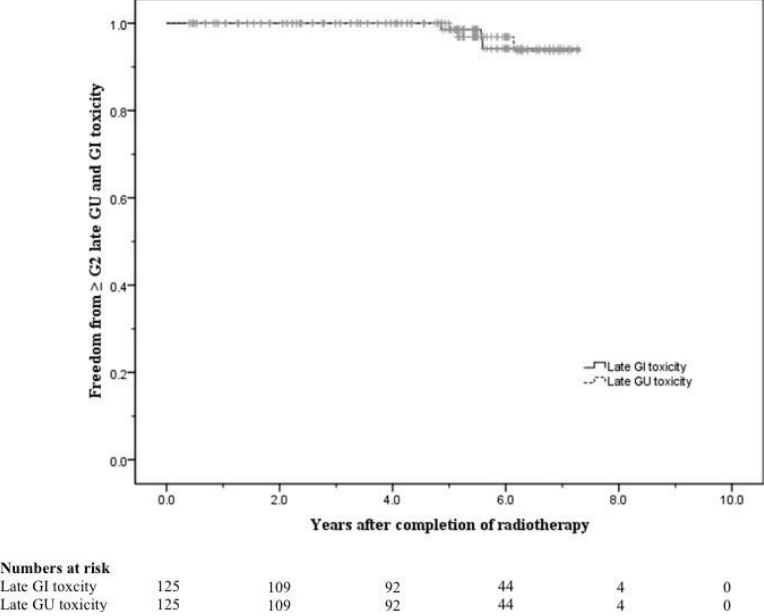
Figure 4. Freedom from ≥ Grade 2 late genitourinary (GU) and gastrointestinal (GI) toxicity.